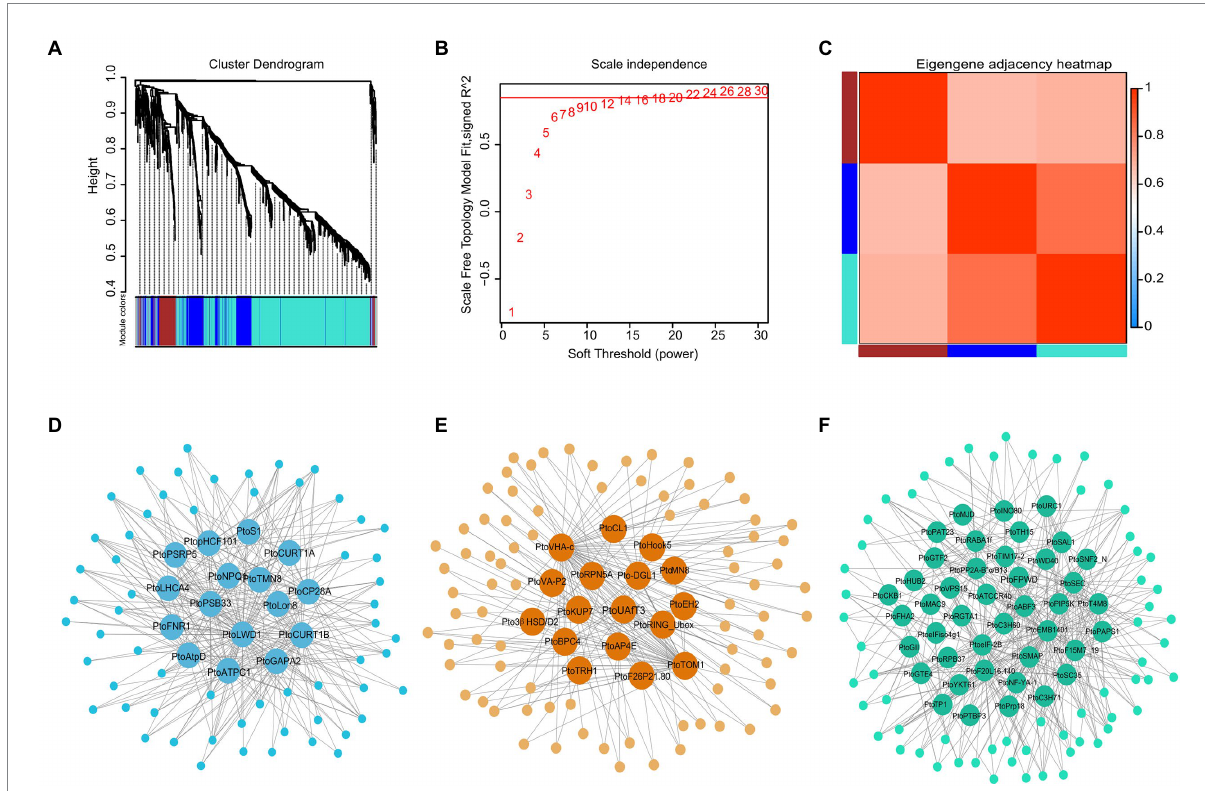
FIGURE 1 Co-expression network of differentially expressed genes (DEGs) in five poplar species. (A–C) Clustering dendrograms of gene expression patterns. Dissimilarity was based on topological overlap, along with assigned module colors. The three co-expression modules are shown in different colors. (D–F) Network relationship among the modules. In total, 16, 17, and 42 hub genes included in the blue, brown, and turquoise modules, respectively. Hub genes with edge weight ≥ 0.5 and node connectivity ≥ 10 were used to construct the network in